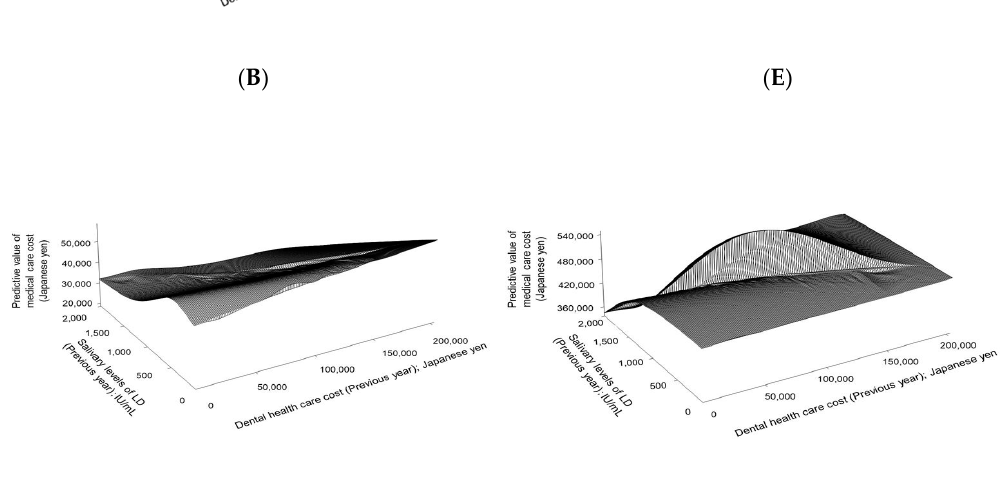
Figure 5. ( A ) Prediction model for medical health care costs; ( B ) medical health care costs from the previous year = 0 (Japanese Yen); ( C ) medical health care costs from the previous year = 100,000 (Japanese Yen); ( D ) medical health care costs from the previous year = 200,000 (Japanese Yen); (E) medical health care costs from the previous year = 500,000 (Japanese Yen); ( F ) medical health care costs from the previous year = 1,000,000 (Japanese